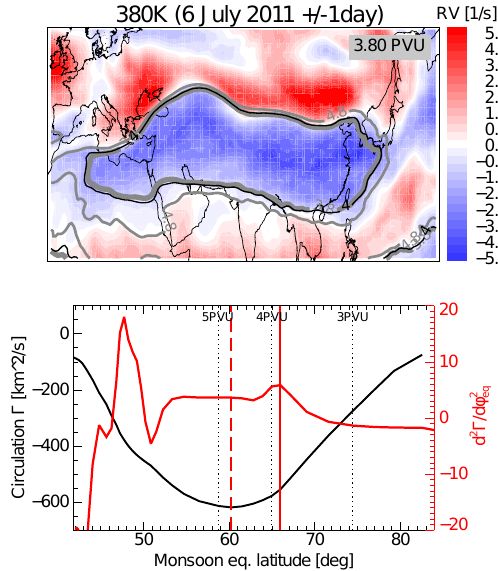
Figure 7. Relative vorticity map at 380K, in the Asian monsoon re- gion between 10–60 ◦ N and 10 ◦ W–160 ◦ E averaged over 5–7 July 2011 (upper panel). The lower panel shows the horizontal circula- tion (calculated from area-integrated relative vorticity) as function of the monsoon centered equivalent latitude (black) and the respec- tive second derivative (red). PV-values corresponding to the mini- mum circulation are shown as thin grey contour (upper panel) and red dashed line (lower), and PV-values corresponding to the maxi- mum in the second derivative of the circulation as thick grey con- tour (upper) and red solid line (lower). The black contour (upper panel) shows the transport barrier PV deduced from the maximum PV-gradient, for comparison. (See text for further details).